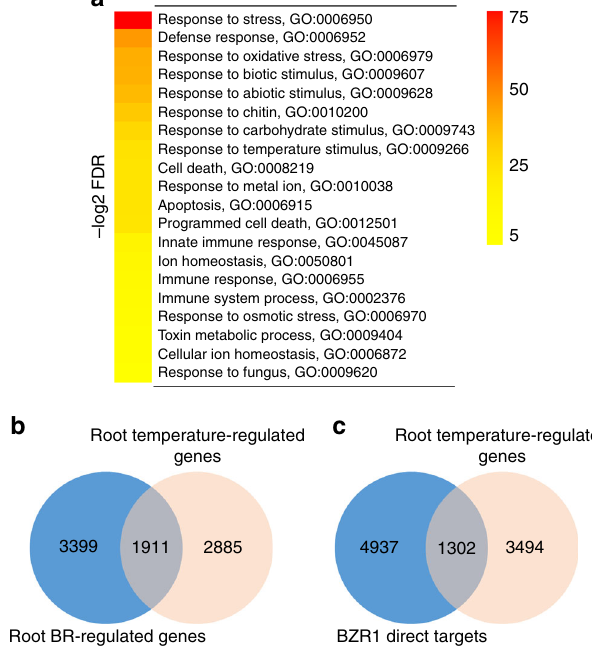
Fig. 3 Genomic responses to prolonged elevated ambient temperature in roots. a Top 20 (ranked by false discovery rate ( FDR < 0.05)) signi fi cantly enriched GO terms derived from genes that are regulated by increased temperature. The range of FDR is shown on the right. b , c Venn diagrams representing the overlap between elevated ambient temperature-regulated genes and published brassinosteroid-regulated genes in roots 21 b , or genes directly regulated by the binding of the BR-regulated